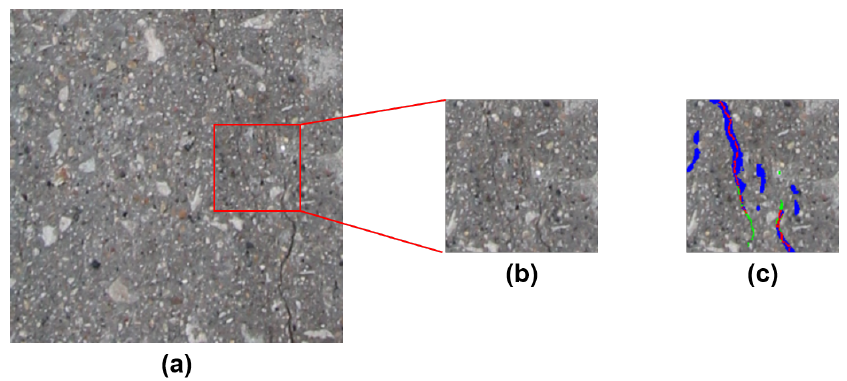
Figure 13. ANet-FSM detection results on images containing very small and vague crack paths. ( a ) The original image. ( b ) The magnification of the area with a vague crack path. ( c ) The detection results of